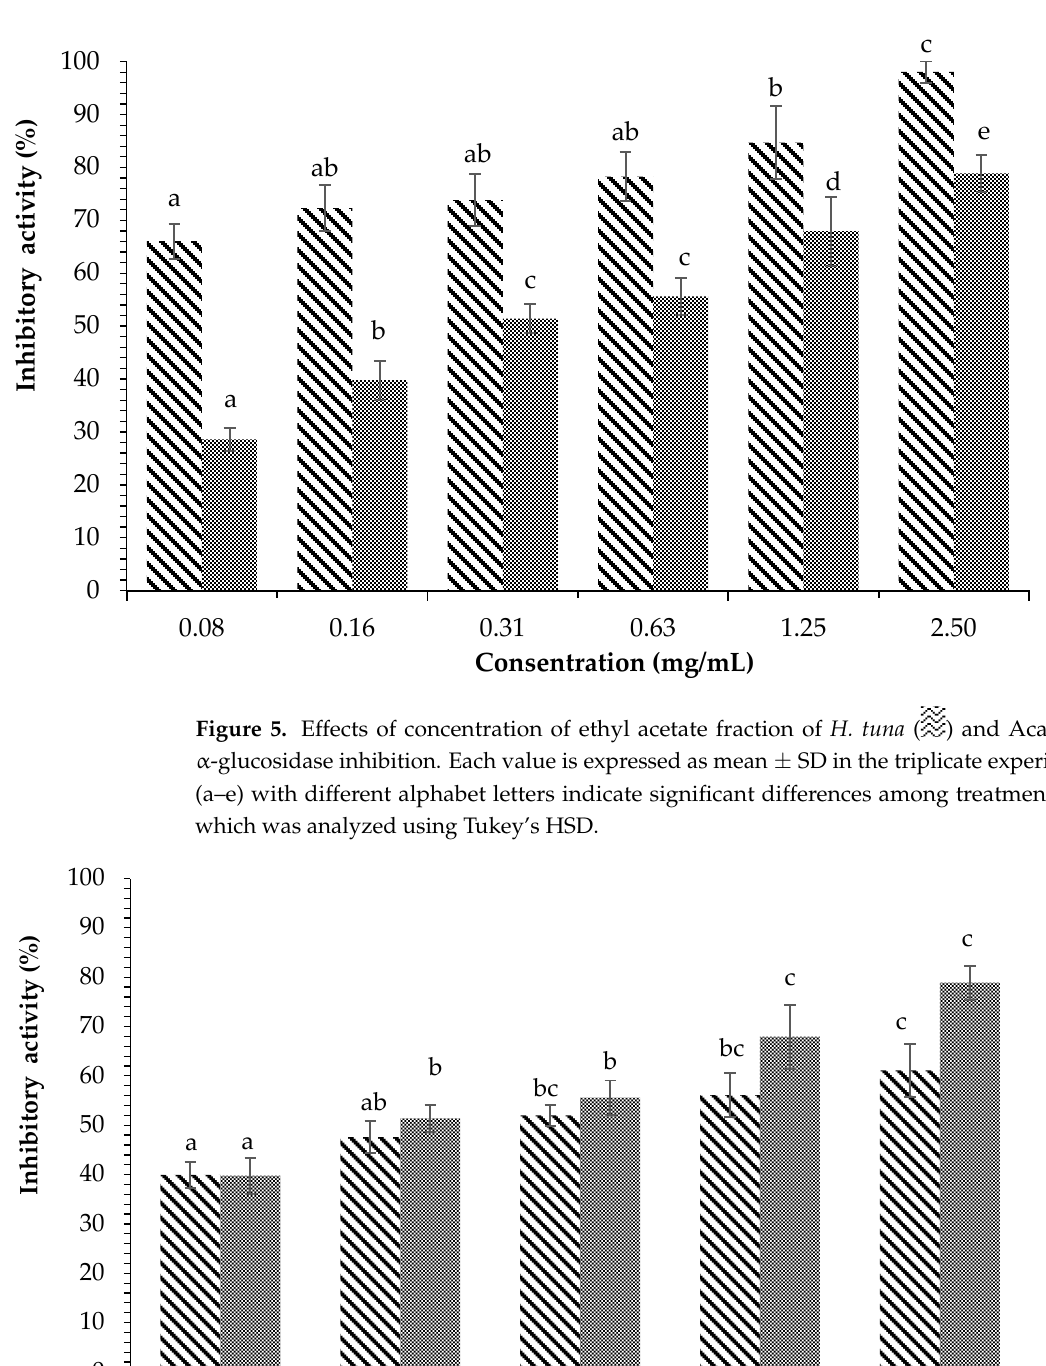
Figure 4. Effects of concentration of methanol extract of H. tuna ( ) and Acarbose ( ) on α -gluco- sidase inhibition. Each value is expressed as mean ± SD in the triplicate experiment. Values (a–d) with different alphabet letters indicate significant differences among treatments at p < 0.05, which was analyzed using Tukey’s HSD.